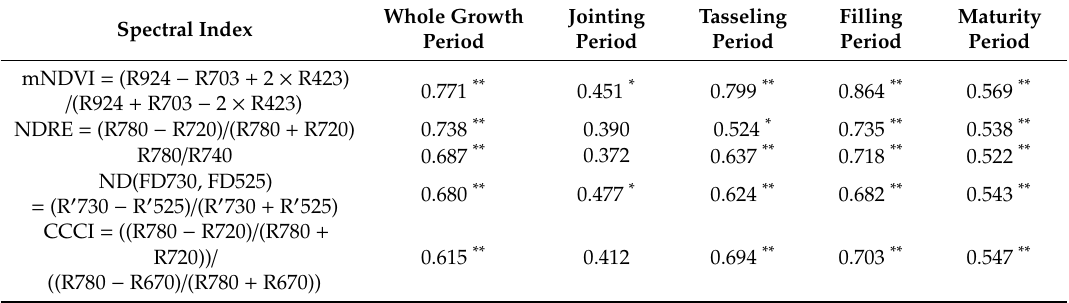
Table 6. Correlation coe ffi cients between corn canopy nitrogen concentration and spectral indexes (two